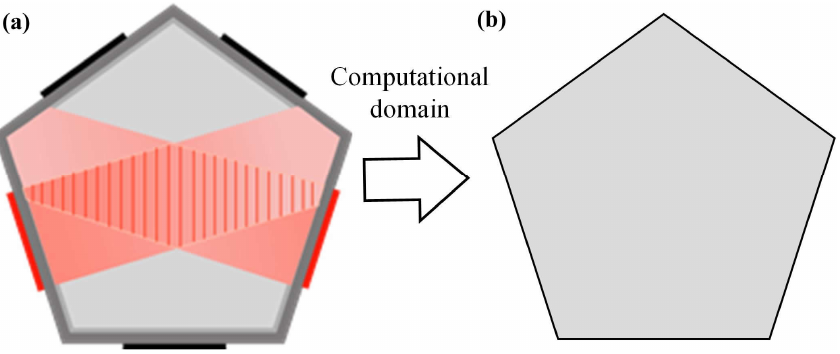
Figure 3. Simulation model of a pentagonal resonator: ( a ) experiment model and ( b ) numerical model.